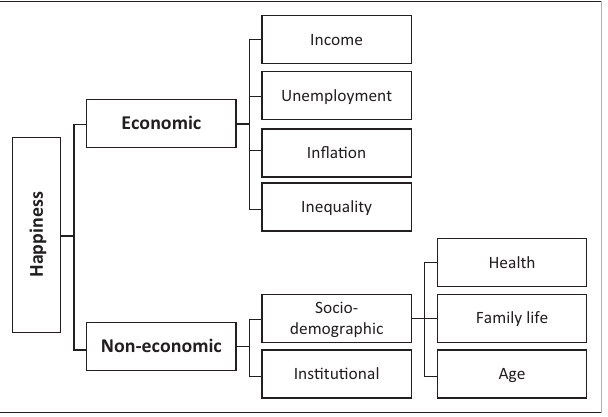
FIGURE 3: Determinants of happiness according to Conceição and Bandura. FIGURE 4: Determinants of happiness according to Dolan et